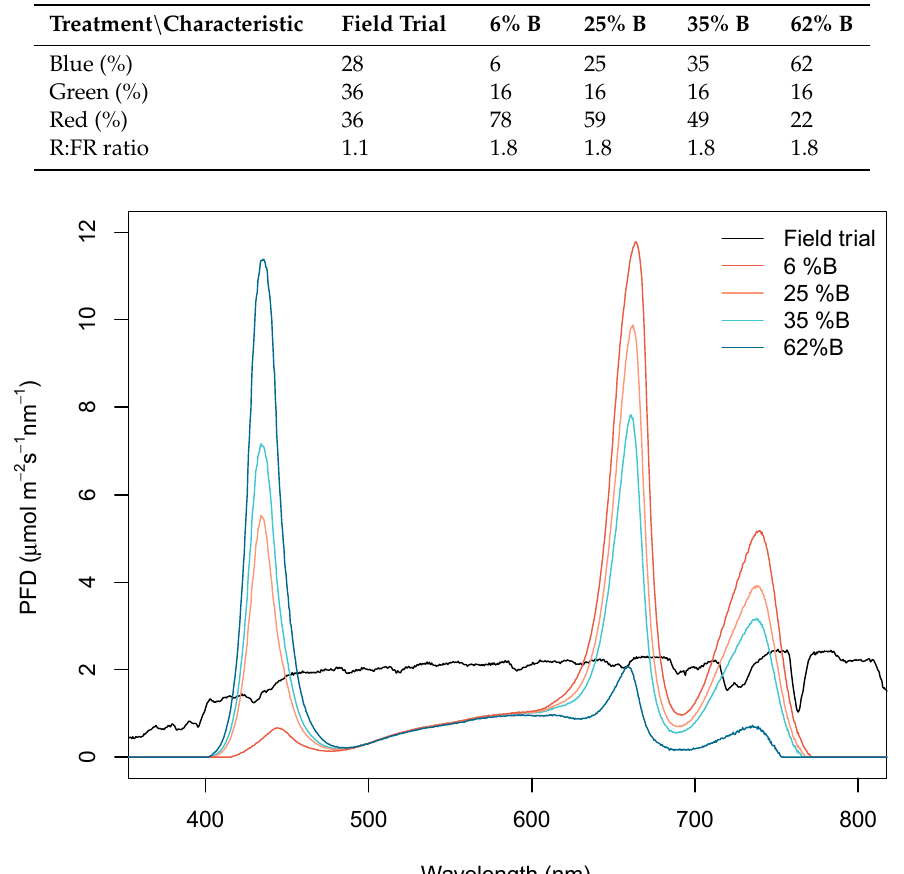
Table 1. Spectral characteristics of sunlight and of the indoor light treatments, based on the measured spectra shown in Figure 1.